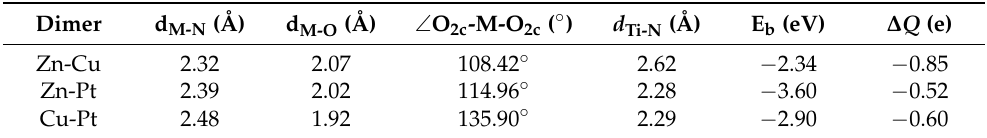
Table 1. Calculated results for bimetal-embedded A-TiO 2 systems, including the distance d M-N between two metal atoms; d M-O and d M-N is the distance of metal M and O (2) , and Ti and metal N atom, respectively. The angle of O 2c -M-O 2c is equal to ∠ O 2c -M-O 2c . The binding energies of bimetallic atoms on A-TiO 2 (101) (E b ) and the charge transfer from A-TiO 2 to bimetallic atoms ( ∆ Q ). M stands for the former metal atom, and N stands for the later one.